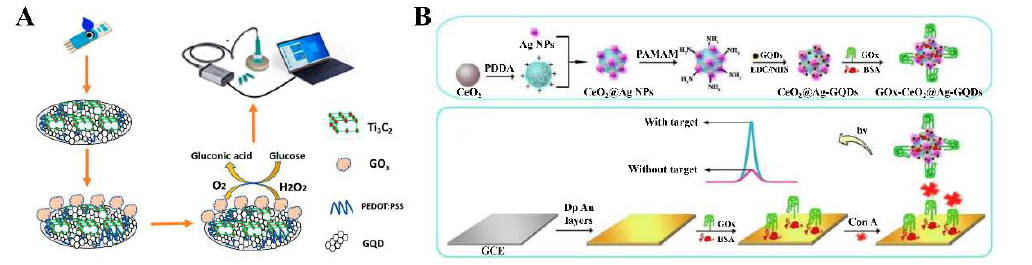
Figure 4. The 2D-QD-based electrochemical enzyme biosensors. ( A ) Fabrication of PEDOT:PSS/Ti 3 C 2 /GQD modified SPCE for glucose detection. Adapted from Ref. [87]. ( B ) Preparation of GOx-CeO 2 @Ag-GQDs and construction of the ECL biosensor. Adapted with permission from Ref. [90]. Copyright 2019 Elsevier.